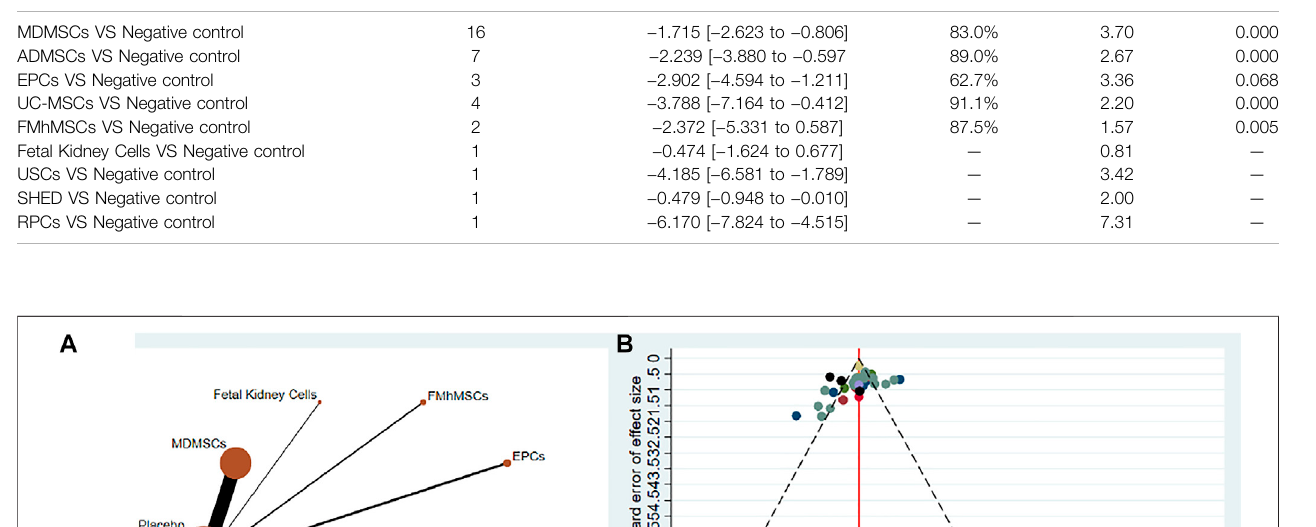
TABLE 7 | Traditional Meta-analysis results of blood urea nitrogen level between stem cell groups and the control group at 1 day after administration. Intervention measures